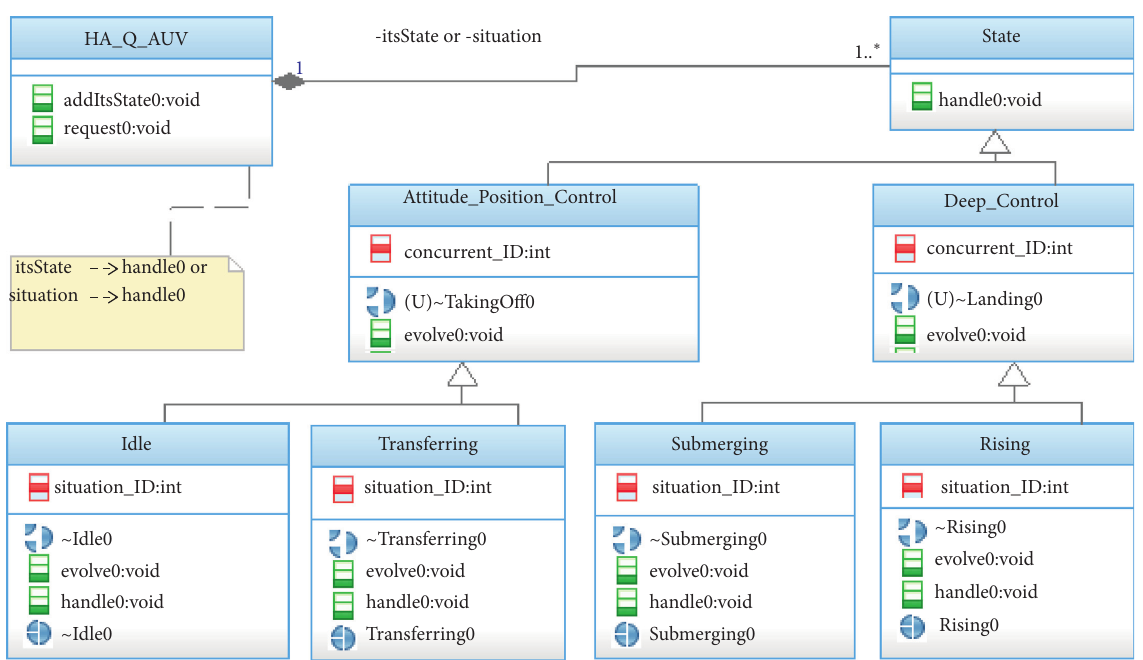
Figure 7: State pattern structure of HA for the AUV